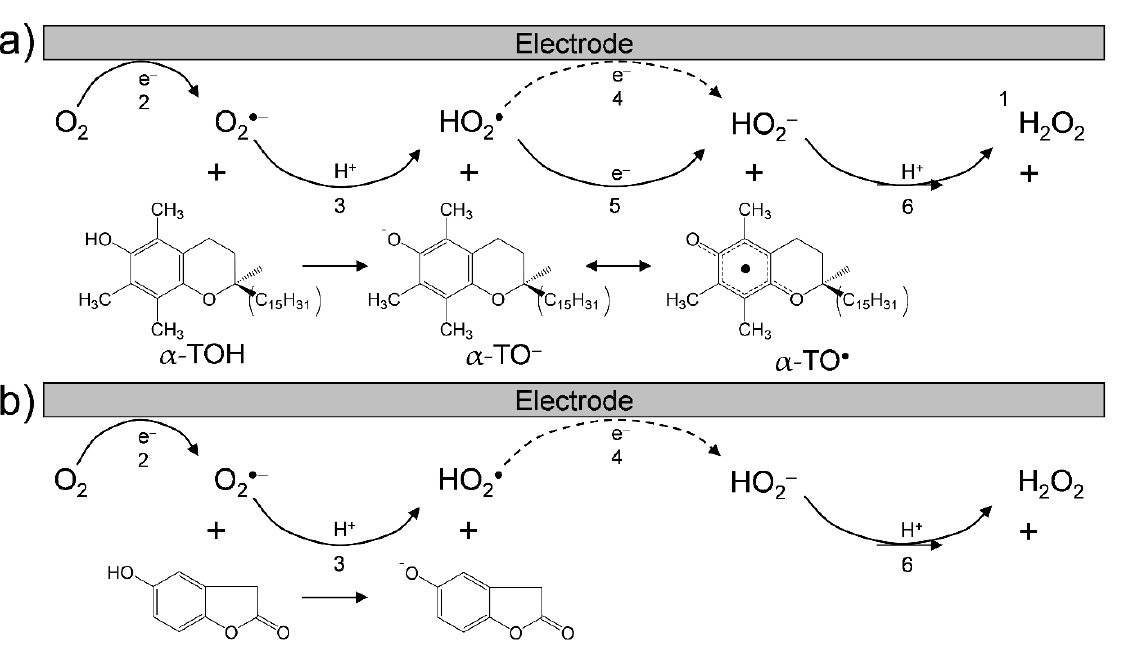
Figure 3. Plausible electrochemical mechanisms of O 2 /O 2 •− in the presence of ( a ) α -TOH and ( b ) homogentisic acid γ -lactone in DMF. 1 The net PCET reaction between 2 α -TOH and O 2 •− forming α